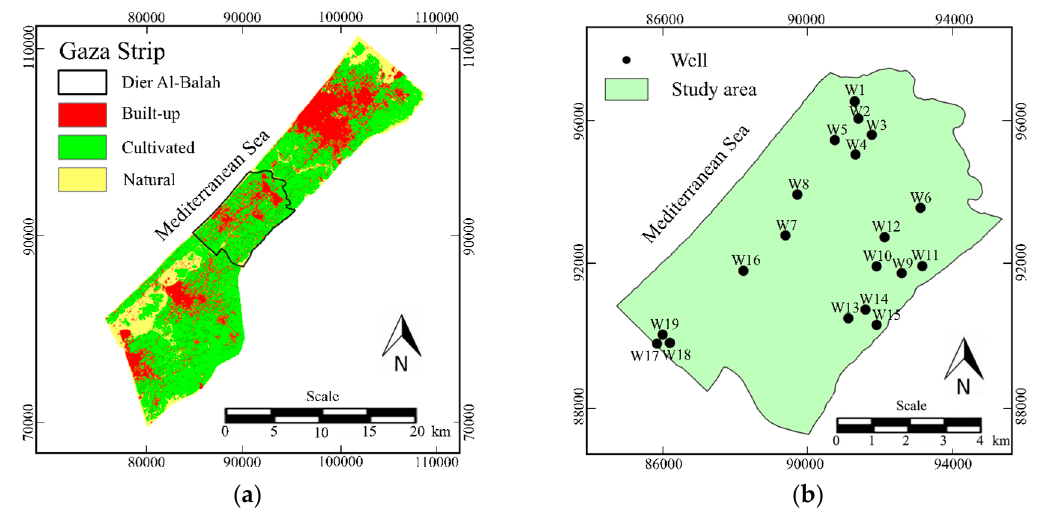
Figure 1. Map of the Gaza Strip with indication of the Dier al-Balah Governorate ( a ); map of the Dier al-Balah Governorate (study area) with the location of the municipal wells used in this study ( b ).